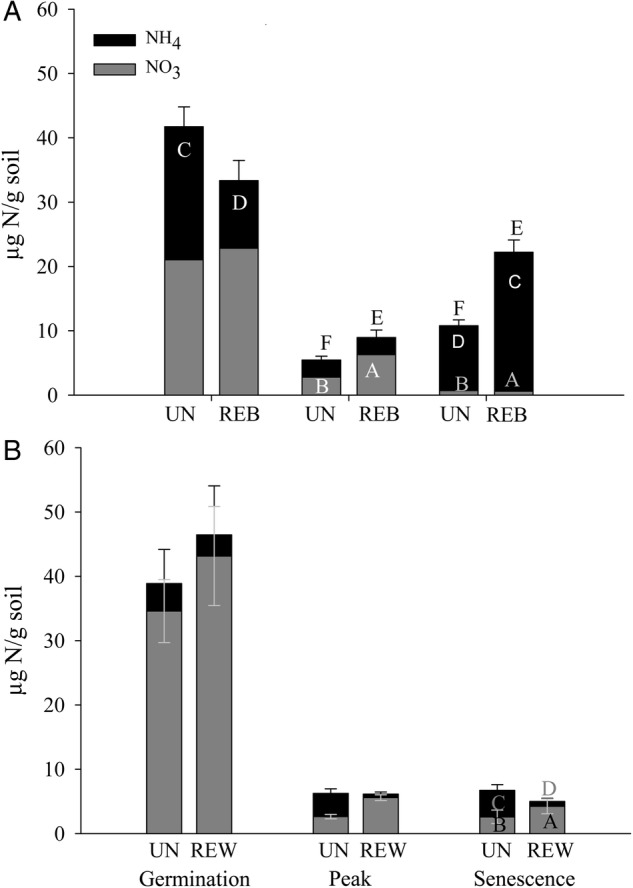
Soil-extractable N during the 2007–08 season at the inland site (A) and the coastal site (B). Treatments are: UN = unrestored, REB = restored by burning at the inland site and REW = restored by weeding and mowing at the coastal site. Letters indicate significant differences using ANOVA followed by Tukey–Kramer HSD test: NO3 = A and B, NH4 = C and D and total extractable N = E and F. Bars indicate standard error and letters significant differences (P ≤ 0.05).